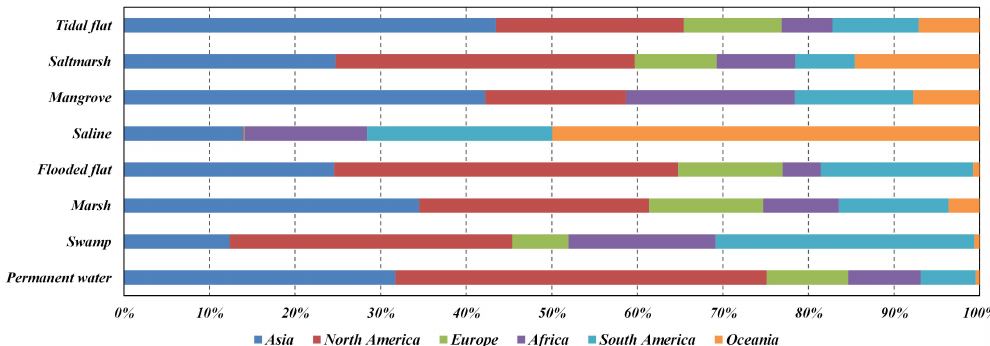
Figure 11. The area proportions of eight wetland sub-categories over each